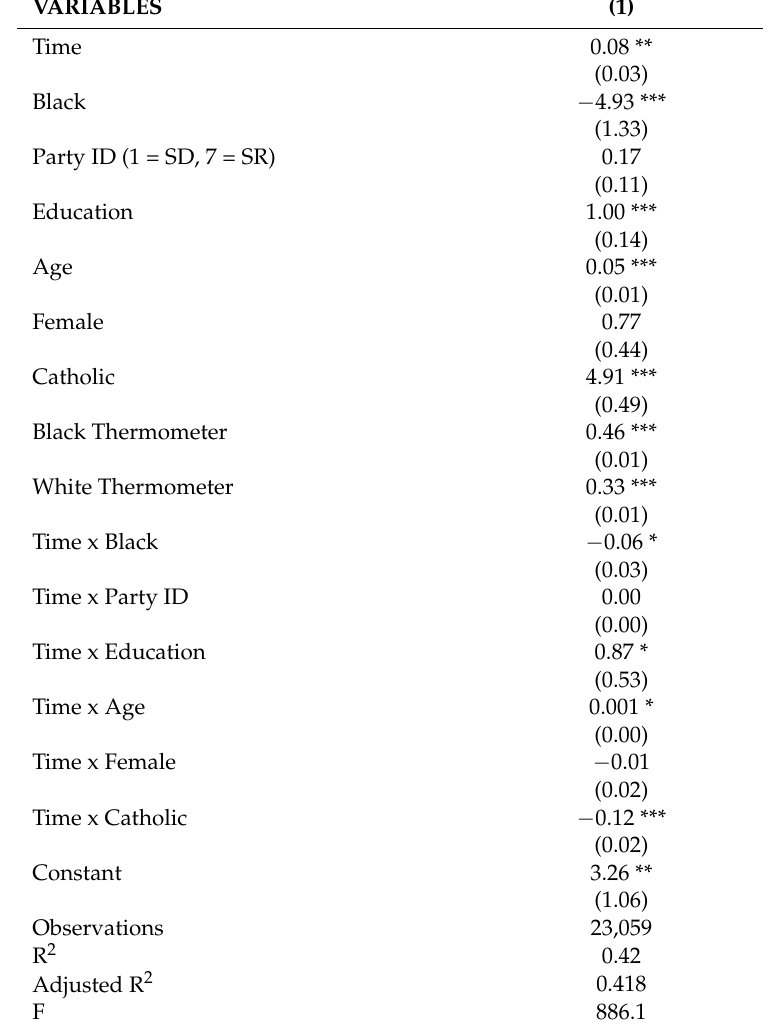
Table 4. Impact of demographics, time, and their interaction in a single equation on Jewish thermometer ratings, ANES